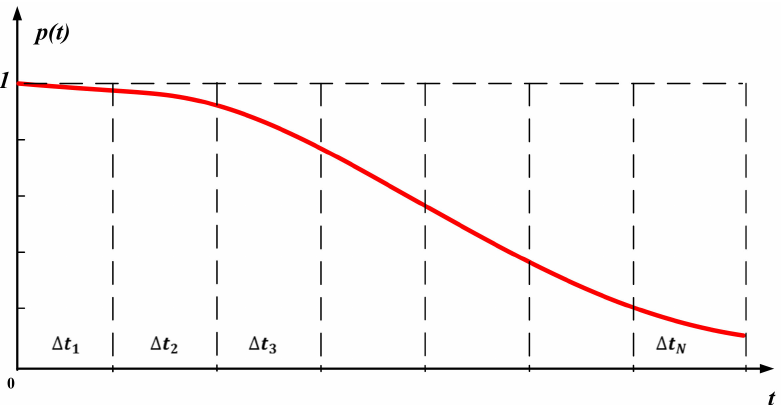
Figure 11. The process of evolutionary dependence of the survivability of the system on